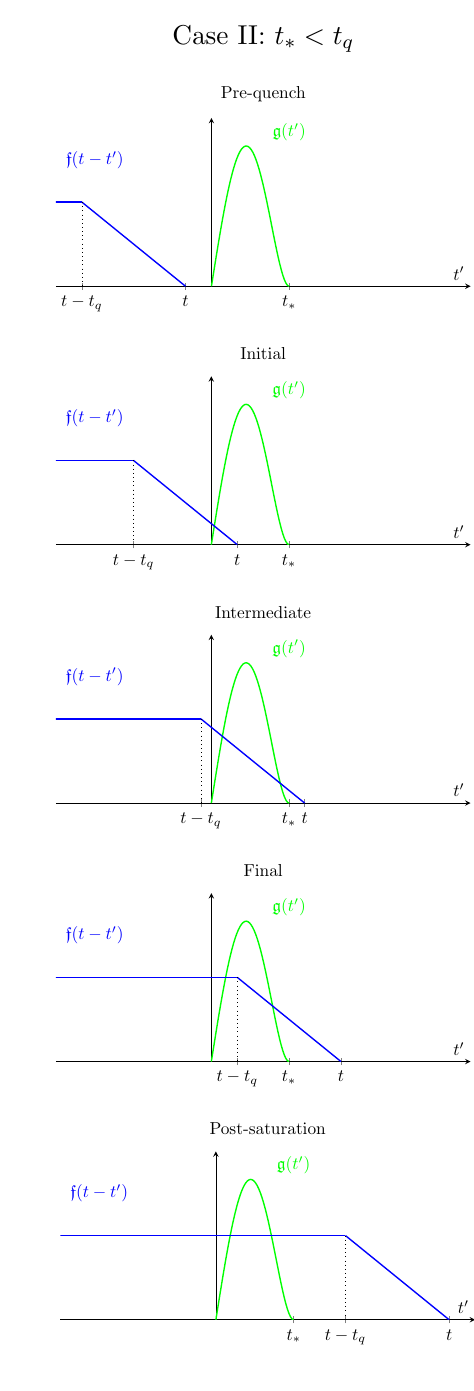
Figure 3 . Schematic representation of the convolution integral for a power-law quench with p = 1. The right and left columns show the two possible cases I: t q < t the pre-quench and post-saturation regimes the integral is a constant. In the initial, intermediate and (cid:12)nal growth regimes the integral is time dependent and can be performed by splitting it in various intervals, as shown in equations (3.23) and